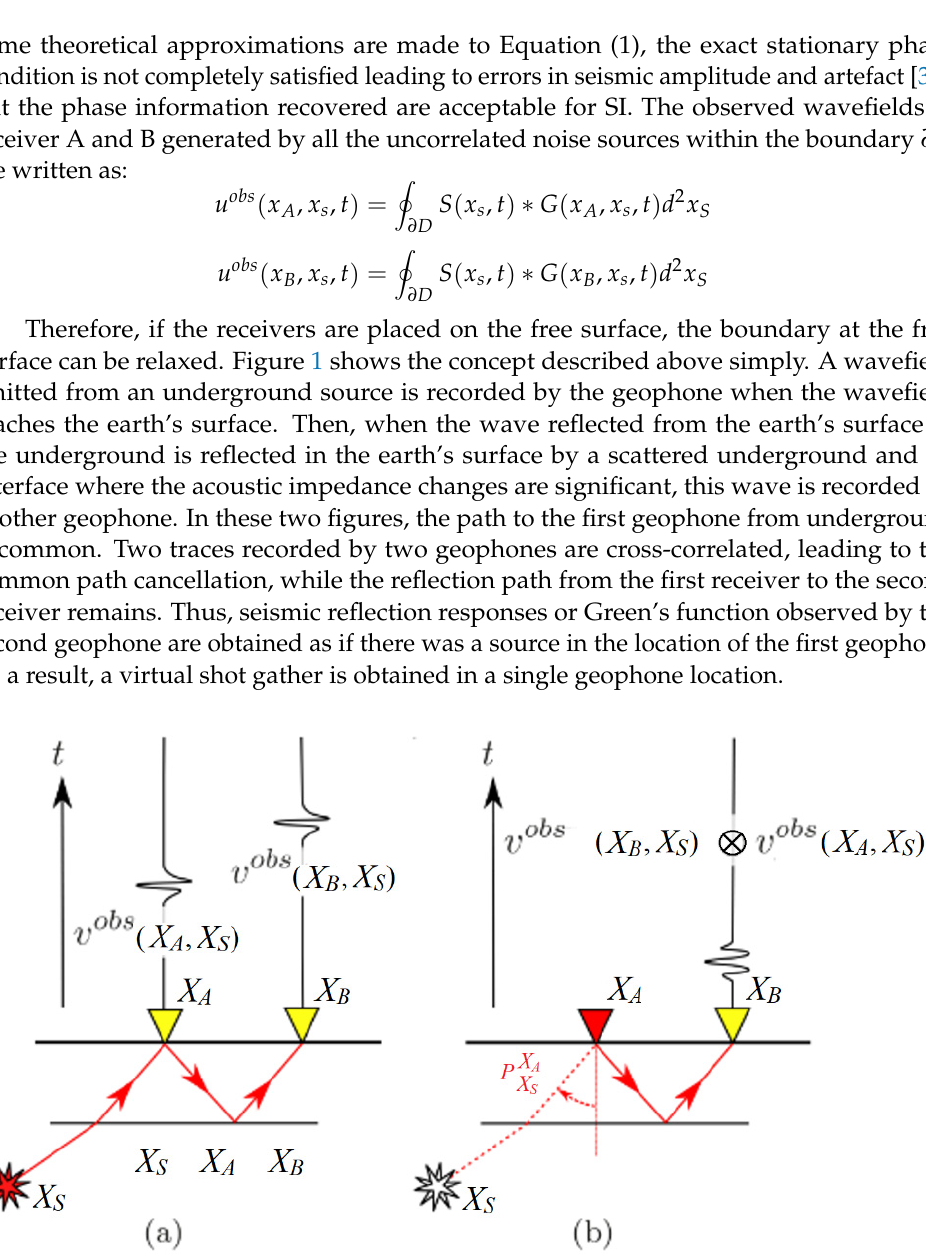
Figure 1. The fundamental principle of reflected-wave interferometry. ( a ) The subsurface source is emitted a signal from underground to the surface and is recorded by two geophones. The second geophone receives the reflected signal by an underground scatterer. ( b ) The cross-correlation cancels the common path from the source X B to the first receiver X 0 , as if a source were located at receiver X 0 . The symbol denotes cross-correlation.